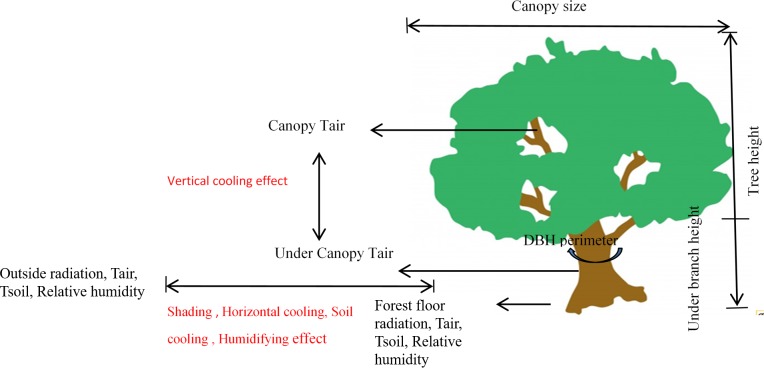
Schematic of the various microclimate parameter measurements and the relative position of measured trees.The shading, horizontal cooling, vertical cooling, soil cooling and humidifying effects from urban trees were calculated from these measurements. Tair and Tsoil are air and soil temperature, respectively. The distance from the canopy shade to forest outside used for microclimate regulation calculation was approximately 10 m.